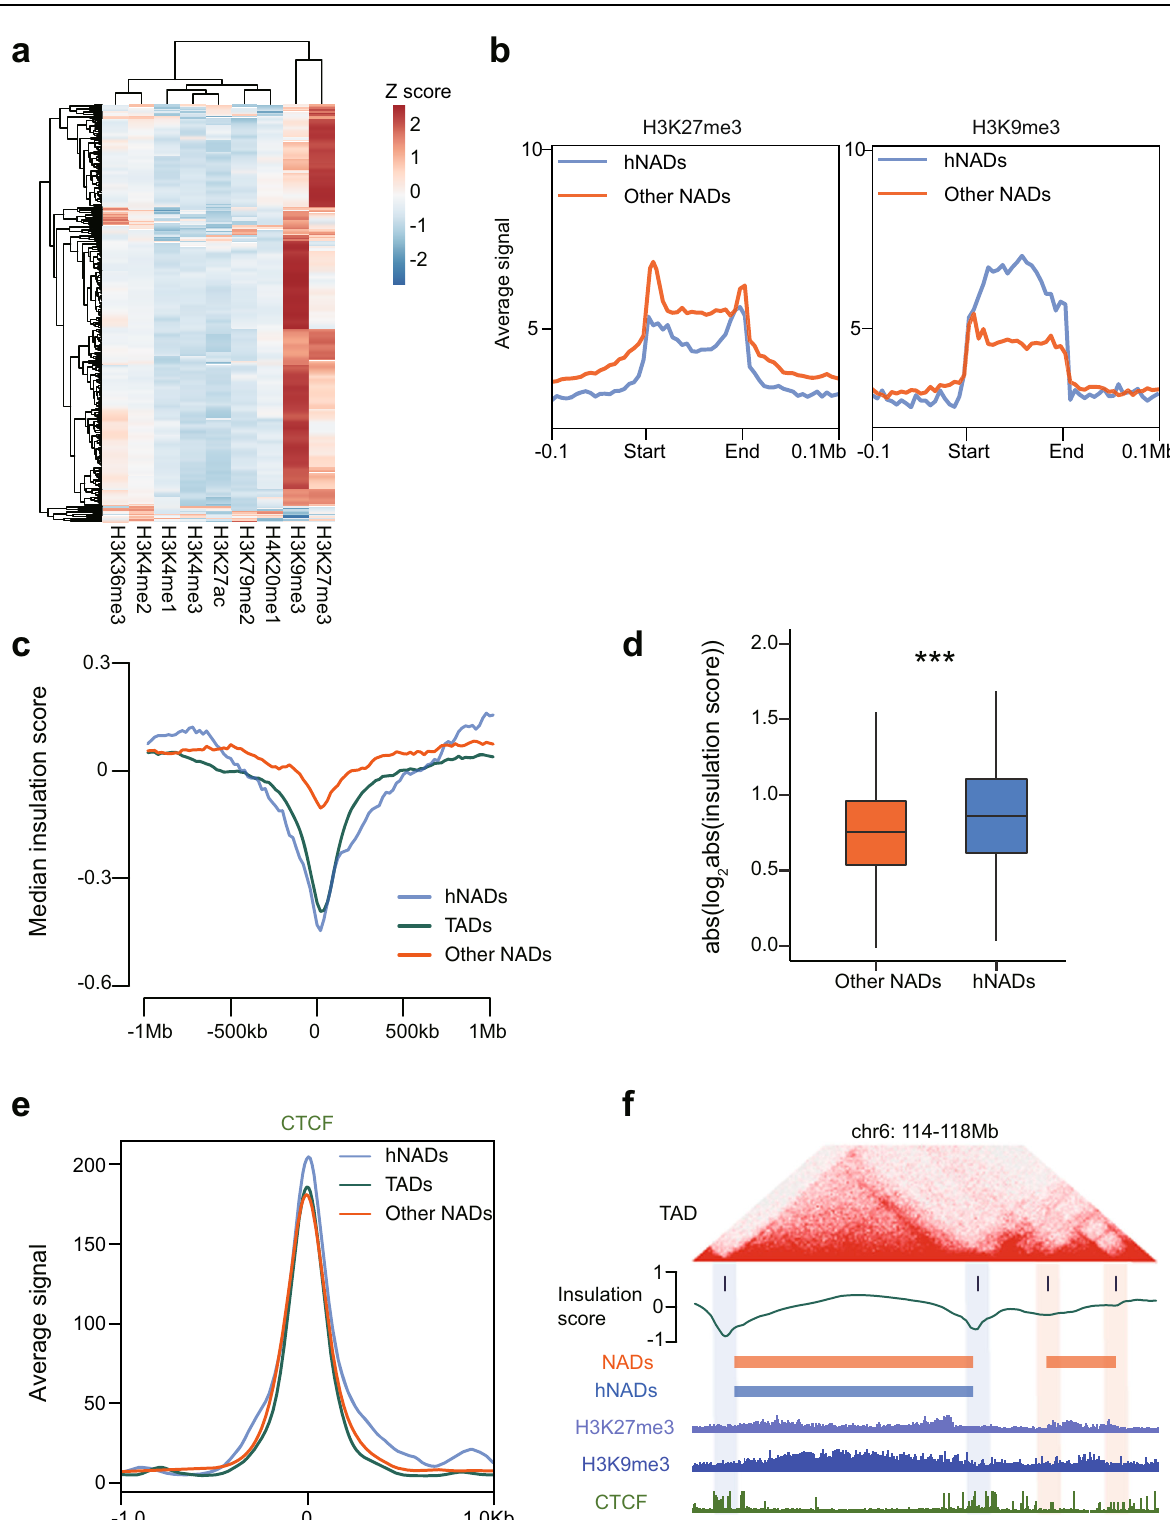
hNAD boundaries, n =726 TAD boundaries overlap with the boundaries of other NADs. Statistically signi fi cant differences were calculated with two-sidedWilcoxon test. *** p <0.001. e CTCF binding signals at hNADs, other NADs, and TAD bound- aries. f An example of overlapping NAD and TAD boundaries. Source data are provided as a Source Data fi